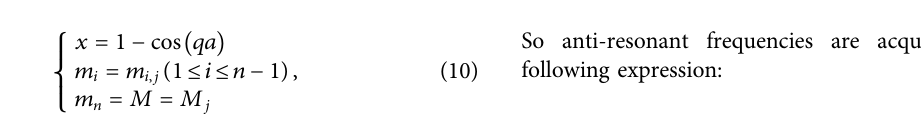
FIGURE 4 | Isosurfaces of the ratios of the width of bandgap region to the maximum frequency of passbands for (A) LR bandgap, and (B) Bragg bandgap.